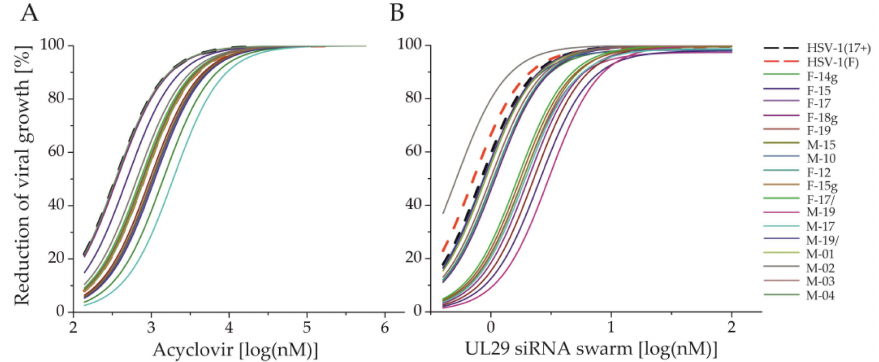
Figure 1. Inhibition of viral shedding in response to ( A ) acyclovir (ACV) or ( B ) UL29 siRNA swarm. The fitted curves represent circulating clinical (solid lines, N = 17) or reference strains (dashed lines, N = 2) of HSV-1. In all antiviral assays, Vero cells were treated with the antiviral agent on 96-well plates, infected 4 h post treatment (hpt) with 100 plaque forming units (pfu) per well, and finally quantified for reduction of viral production into the culture medium at 72 hpt. The dose is shown as log (nM) for both antivirals. The response is shown as inhibition percentage (%) in comparison to untreated cells for ACV and to water-treated cells for the UL29 siRNA swarm. The ACV plaque reduction assay was conducted in duplicates, and the antiviral siRNA swarm assay with five or more biological replicates for each